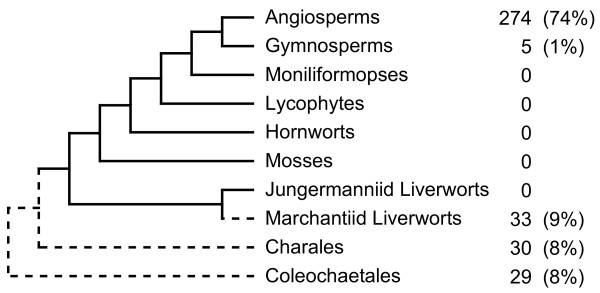
Skewed phylogenetic distribution of sequences in the Aligned Sequence Database. Shown are the number of sequences in the ASD for each lineage and the percentage of the total number of sequences. Editing information is available for several genes from the underrepresented groups, but they were not included in the ASD because only portions of the genes were analyzed. The dotted lines indicate lack of RNA editing based on previous predictive and experimental analyses (see main text). The marchantiid liverworts are thought to have secondarily lost the ability to perform RNA editing. The relationship between plant lineages was taken from Knoop [33].